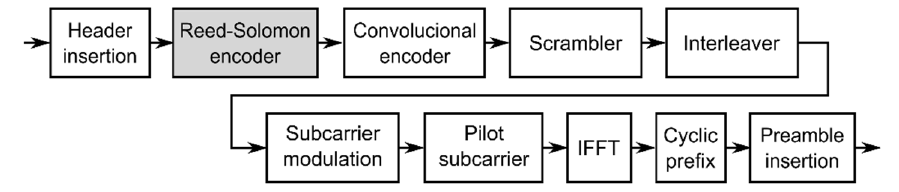
Figure 3. PRIME physical layer transmission diagram introducing Reed–Solomon.